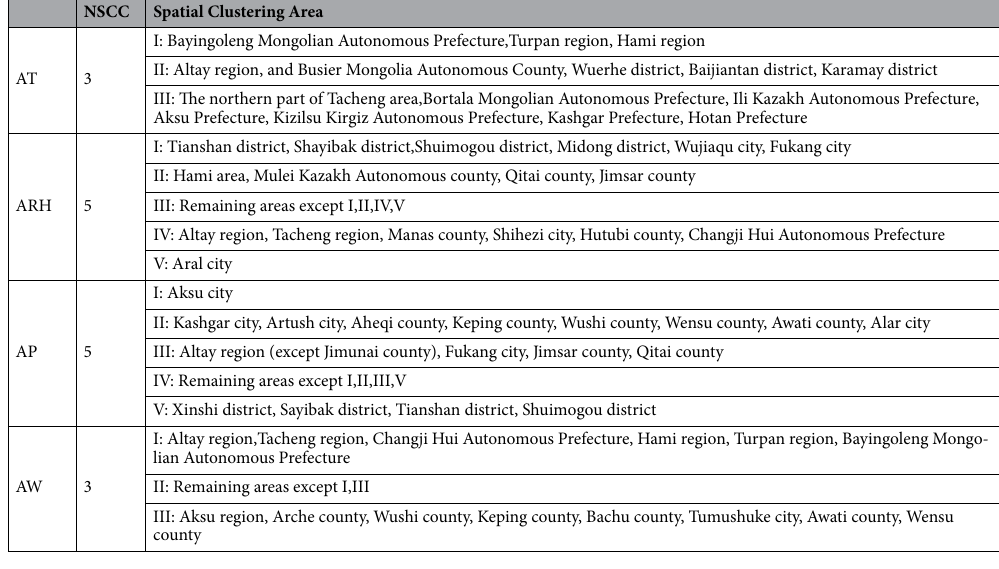
NSCC Spatial Clustering